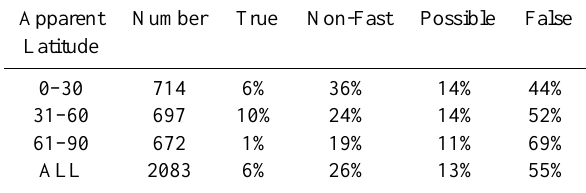
Table 2. Fast CACTus CMEs a